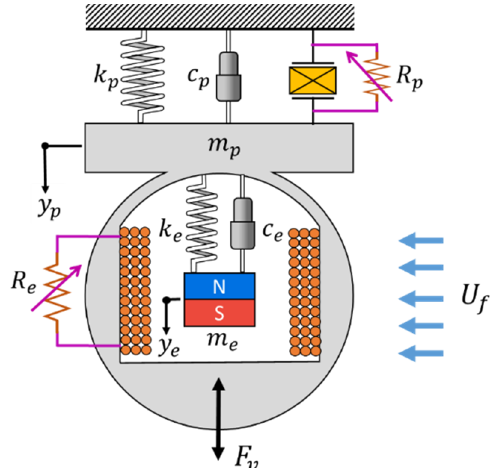
Figure 3. The equivalent lumped-mass model for the hybrid energy harvester.